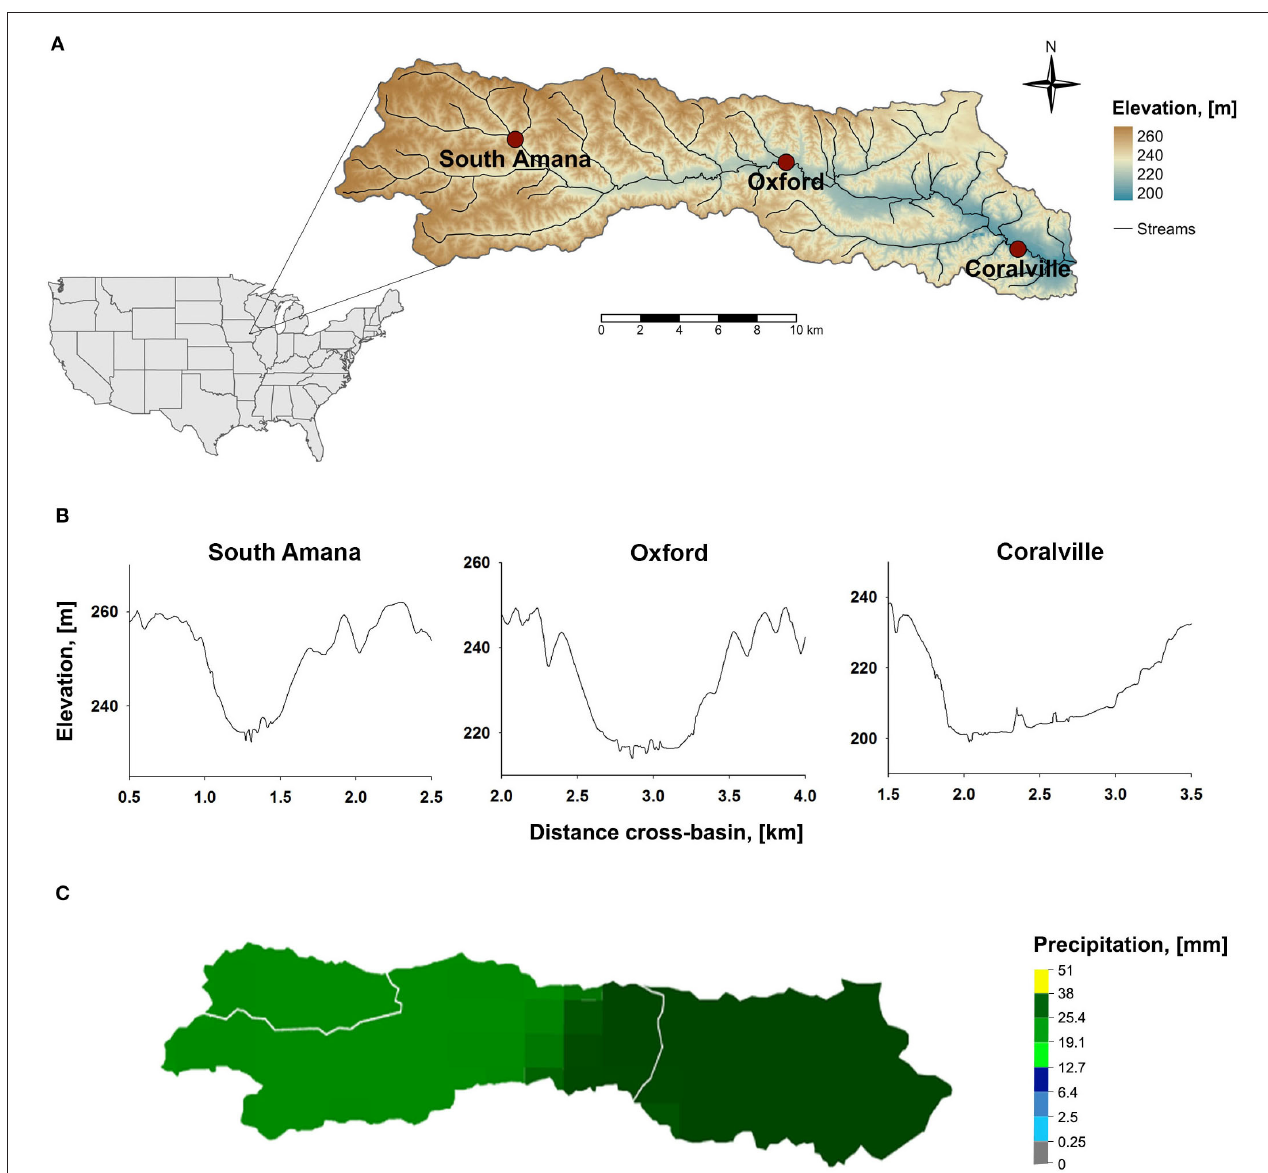
FIGURE 1 | (A) Map of Clear Creek watershed and locations of sampling stations; (B) Valley cross-sections at the sampling stations. Cross-section elevations were obtained from DEMs of the watershed using ArcGIS Pro.; (C) Precipitation estimates in Clear Creek for Oct 27 local time when ∼ 90% of the rain fell. Data were retrieved from The National Weather Service Advanced Hydrologic Prediction